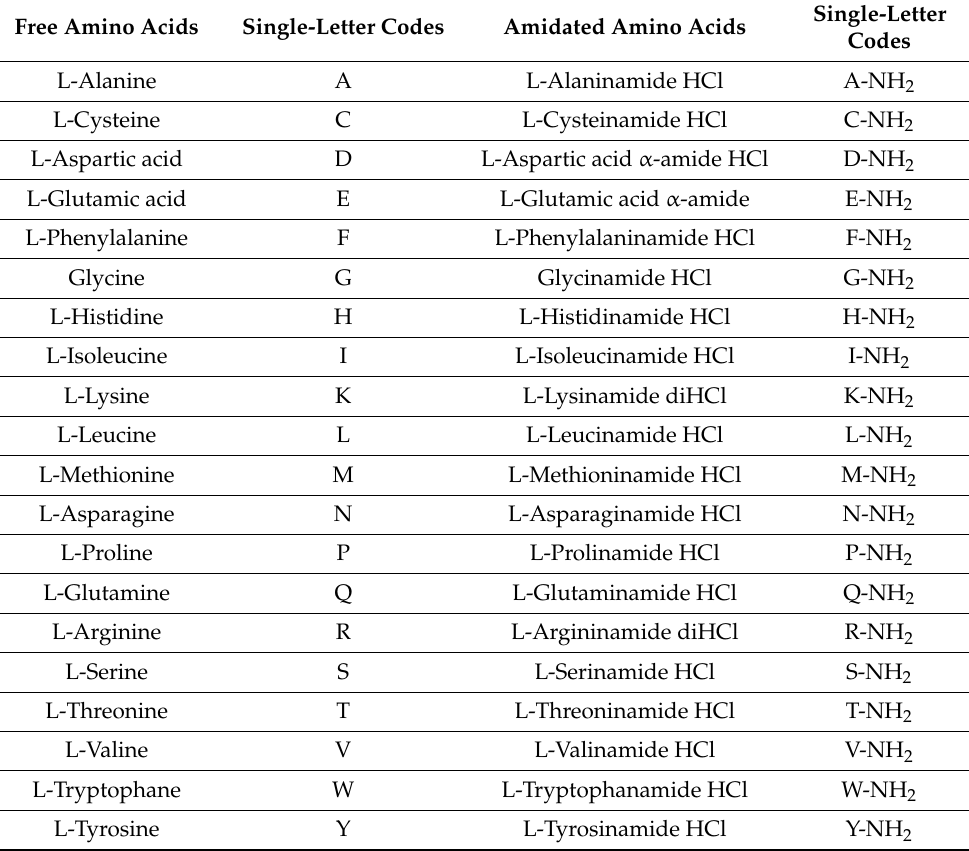
Table 1. Single-letter codes for free and amidated amino acids used in this